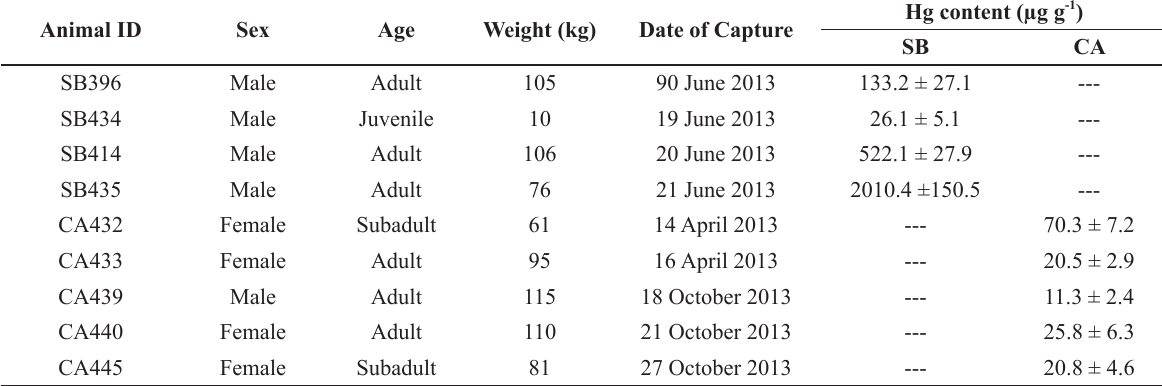
Biological data and Hg levels (µg g -1 dry weight) in the fur of individual jaguars captured in two areas (SB; CA). Hg content is presented as mean ± SD (µg g -1